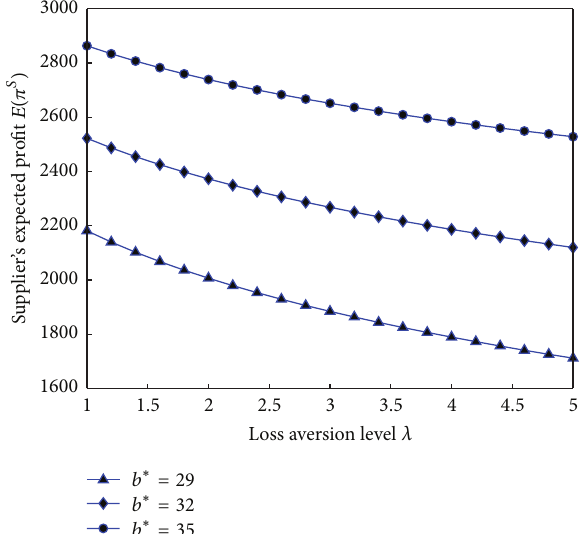
Figure 5: Plot of the supplier’s expected profit with 𝜆 under different values of 𝑏 ∗ .